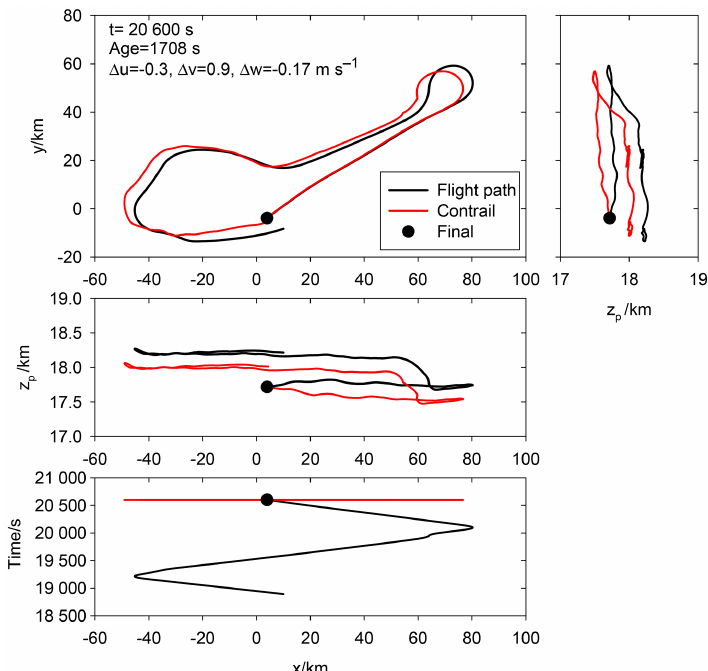
Figure 3. Geophysica flight path (black line with final Geophysica position identified by a black circle) and advected plume position (red line, “contrail”) in four dimensions, between t 1 = 18892s and t 2 = 20600s (age = 1708s, event E1) of 30 November 2005. Also given are the velocity component increments (cid:49)u , (cid:49)v , and (cid:49)w , which are necessary for a perfect match of the final position (black symbol) and the position of the oldest plume part (open end of red